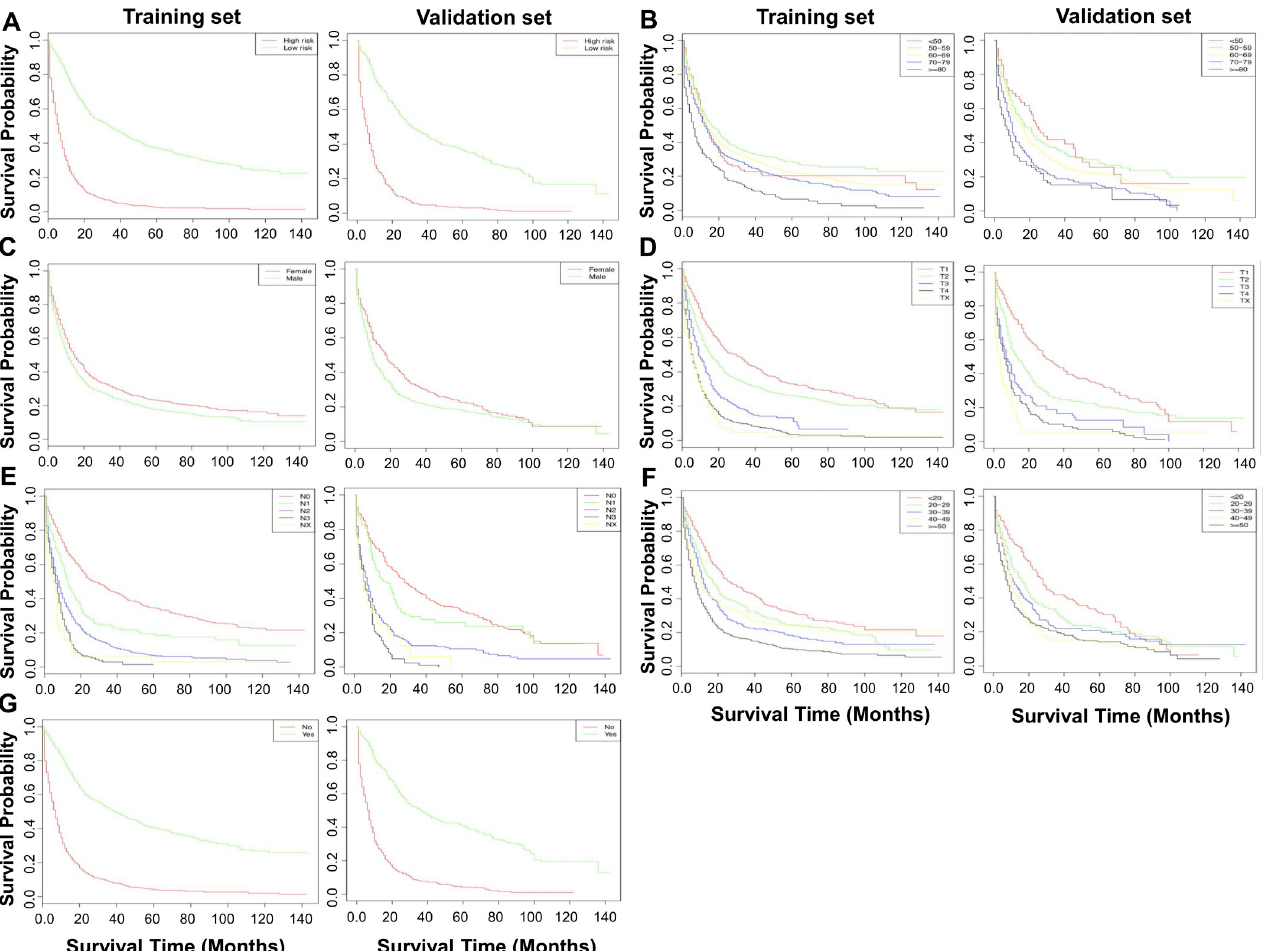
Fig 3. Kaplan-Meier curves of OS in the training and validation sets by (A) risk score, (B) age at diagnosis, (C) gender, (D) tumor stage, (E) N stage, (F) tumor size, and (G) surgery of primary